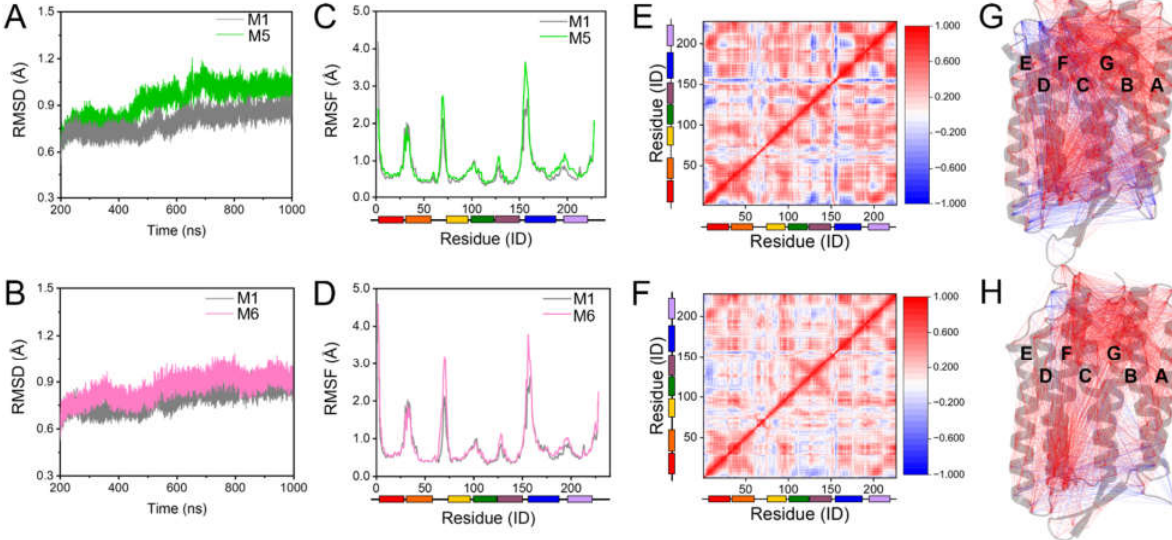
Figure 6. The influence of the W80∙∙∙S-TGA-1 and K129∙∙∙S-TGA-1 interactions on the dynamic stability of the bR trimer. ( A , B ) Time evolutions of the RMSDof the Cα atoms during the simulations; ( A ) M1 (grey line) vs. M5 (membrane containing the W80A-bR trimer, POPC, S-TGA-1, and PGP-Me lipids, green line); ( B ) M1 vs. M6 (membrane containing the K129L-bR trimer, POPC, S-TGA-1, and PGP-Me lipids, pink line); ( C , D ) time evolutions ofRMSF of the Cα atoms: ( C ) M1 vs. M5; ( D ) M1 vs. M6; ( E , F ) DCCM analyses of the Cα atoms for M5 and M6. The color scale represents the correlation intensity from the maximum negative value (−1) to the ultimate positive value (+1); ( G , H ) DCCN analyses of residue–residue cross-correlations for M5 and M6. The grey cartoon represents the bR structure of Monomer1, and blue and red lines indicate the negatively and positively correlated motions, respectively.